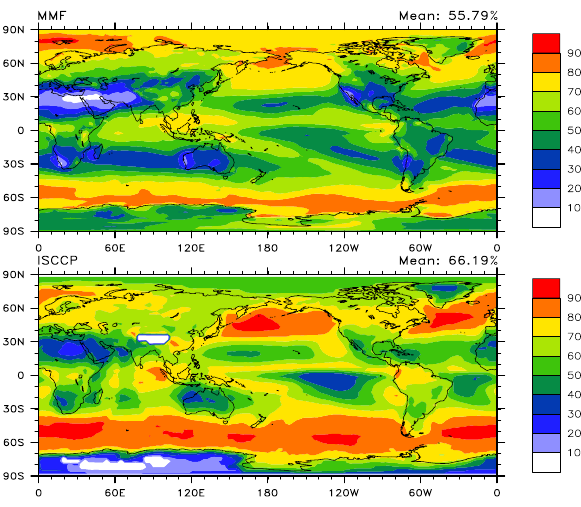
Figure 03 Fig. 3. PD annual average cloud fraction from the MMF model (upper panel) and from the ISCCP observations (lower